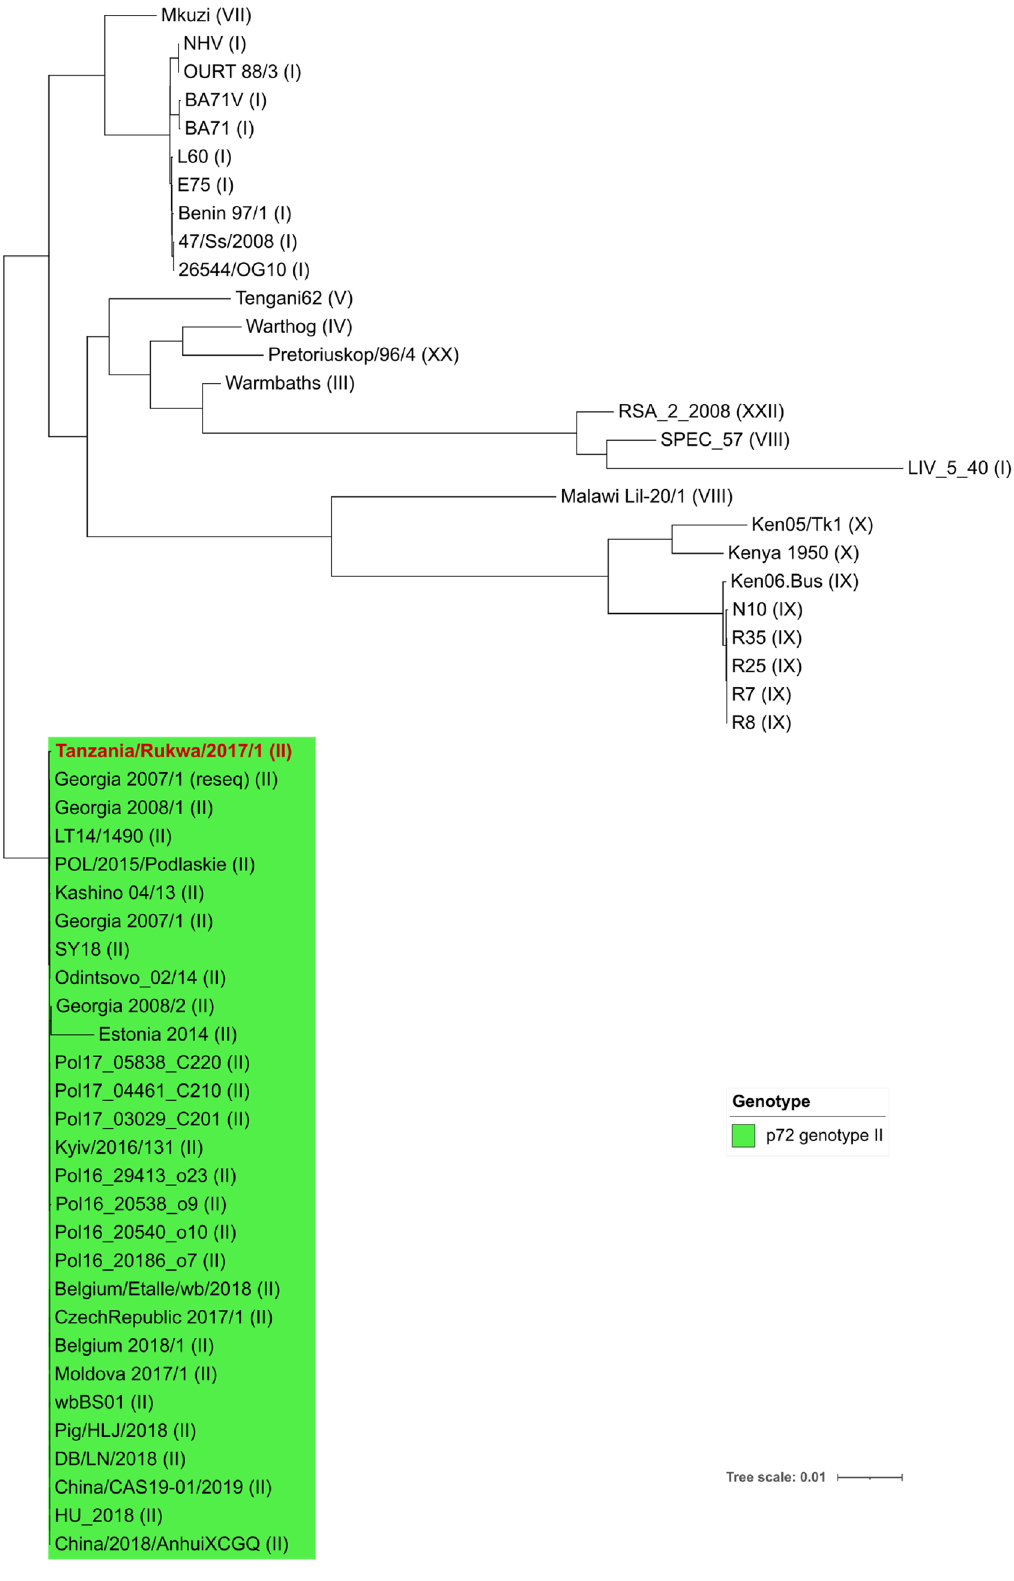
Figure 4. Maximum-likelihood phylogenetic tree showing the relationship between the sequence of Tanzania/ Rukwa/2017/1 determined in this study (highlighted in red), and 54 additional full-length ASFV sequences retrieved from the public databases. The branch length unit is the number of expected substitutions per